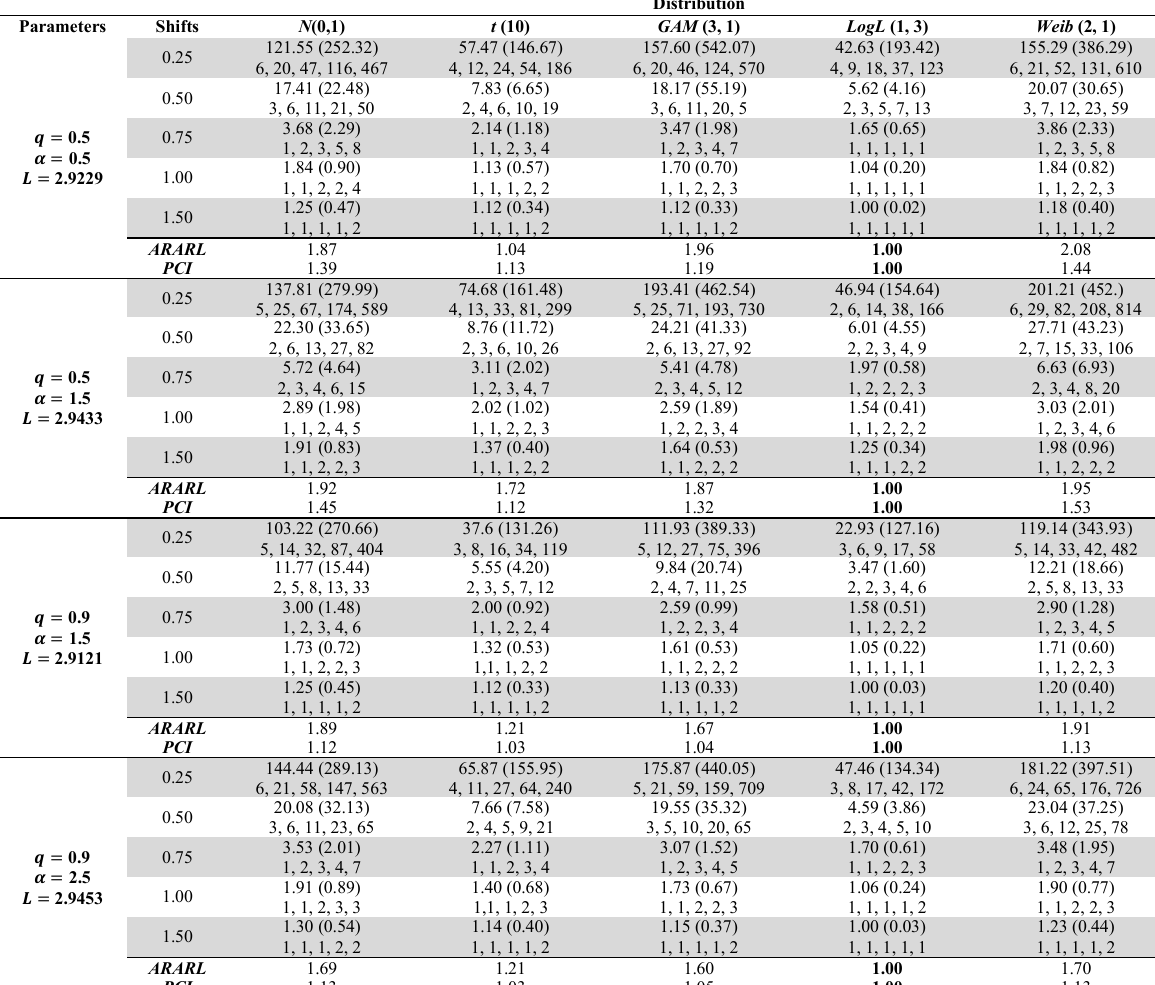
Case E OOC characteristics of the run-length distribution and overall performance of the W-GWMA scheme when ( m , n ) = (100, 5), 𝛼 = 0.5, 1.5 & 2.5, 𝑞 = 0.5 & 0.9 and 𝛿 value of